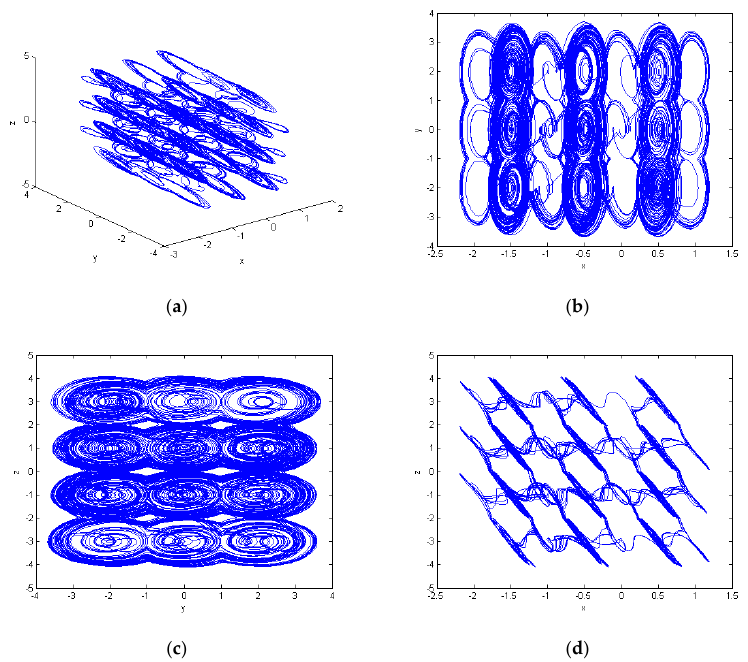
Figure 4. (Color online) chaotic attractor with 3 × 4 × 3-scroll of system (2) with n 1 = 2, n 2 = 1, f 1 ( y ) = f 11 ( y ) , f 2 ( z ) = f 22 ( z ) , N 11 = 0, N 22 = 1, and ( x 0 , y 0 , z 0 ) = ( 0.1,0,0 ) : ( a ) phase diagram in three-dimensional space; ( b ) projection on the x–y plane; ( c ) projection on the y–z plane; and ( d ) projection on the x–z plane. Type 4: n 1 = 0, n 2 = 3, f 1 ( y ) = f 12 ( y ) , f 2 ( z ) = f 22 ( z ) , N 11 = 1, and N 22 = 1, the chaotic attractors